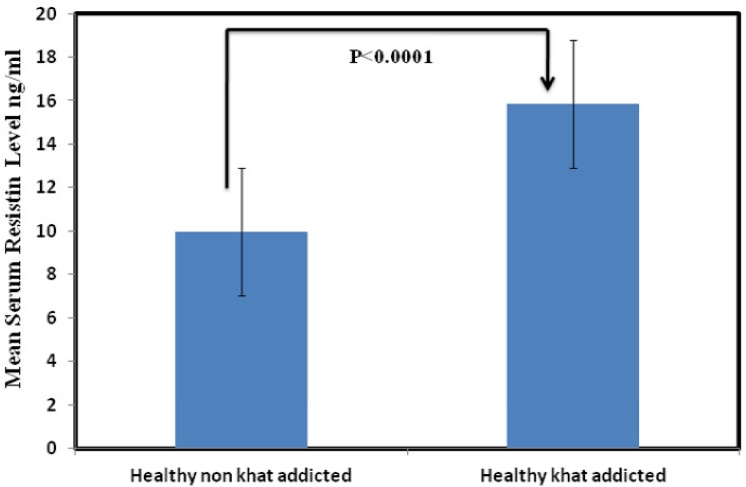
Comparison of mean resistin levels between Non khat addicted and khat addicted subjects.Serum resistin is significantly up regulated among the khat addicted healthy subjects.